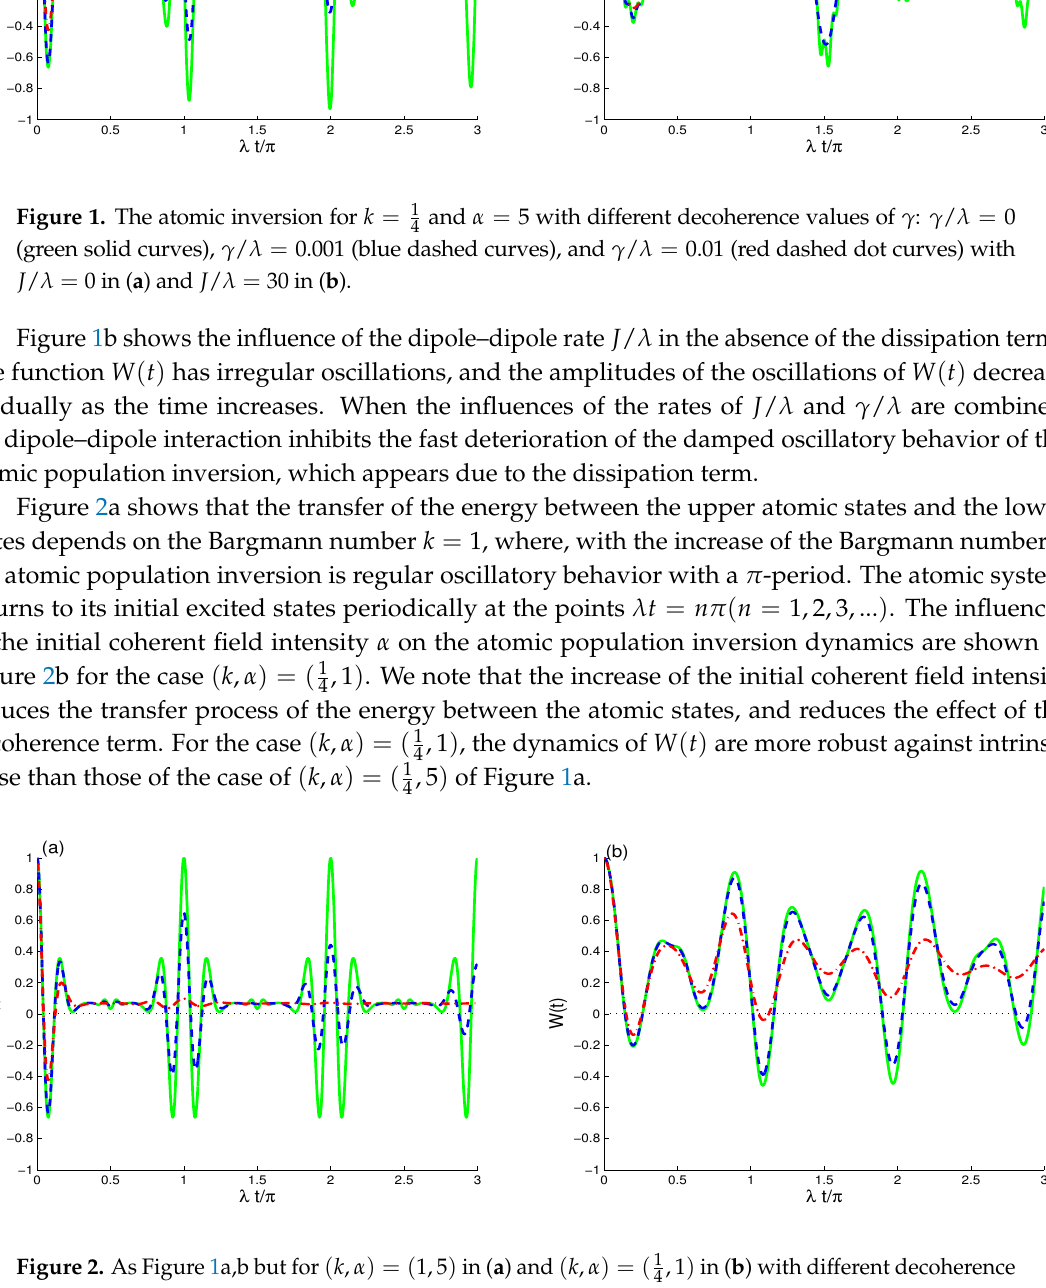
,1 ) in ( b ) with different decoherence 4